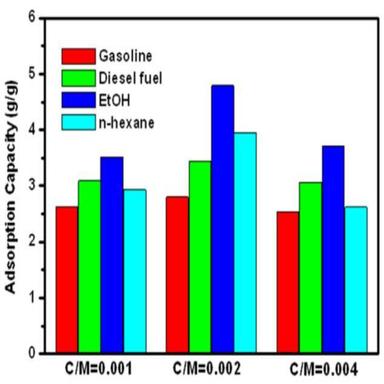
The adsorption capacity for the solvents of gasoline, diesel fuel, EtOH and nhexane using the CTAB-modified PMSQ aerogels with C/M molar ratios of 0.001, 0.002 and 0.004. Reprinted with permission from Ref..